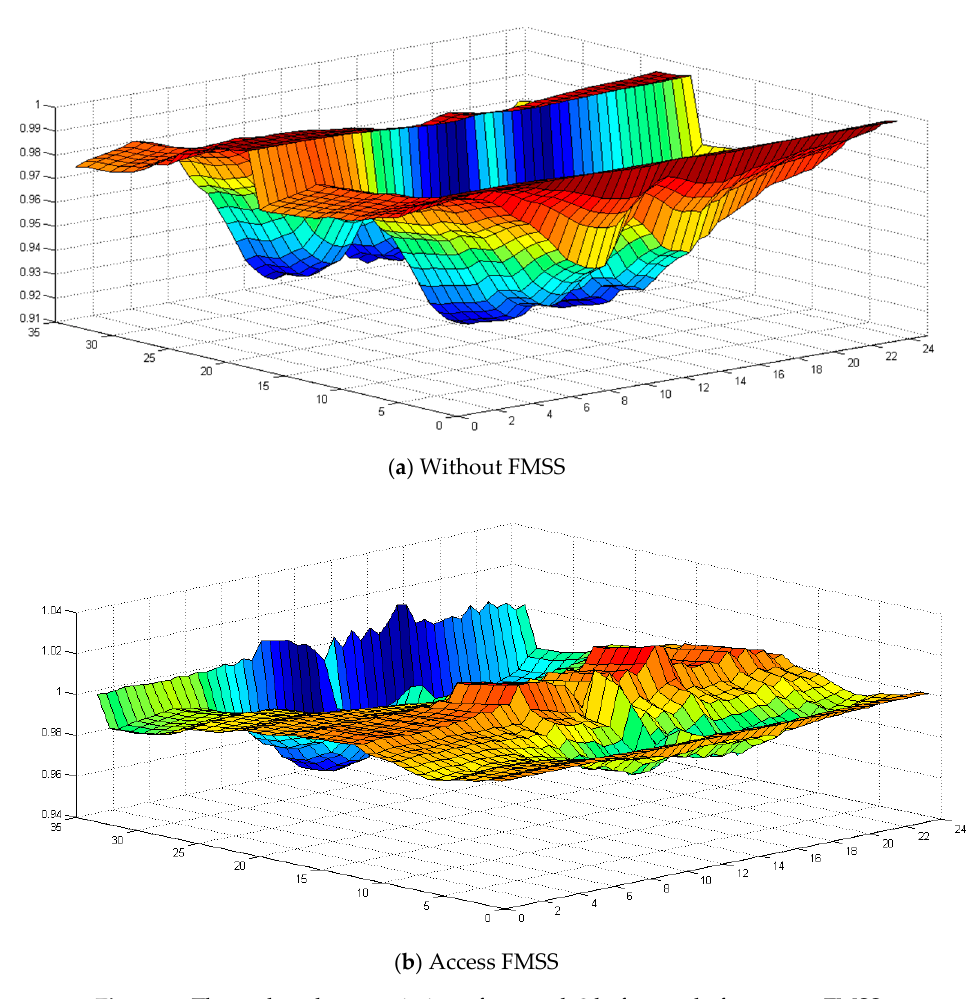
Figure 8. The node voltage variation of network 3 before and after access FMSS.